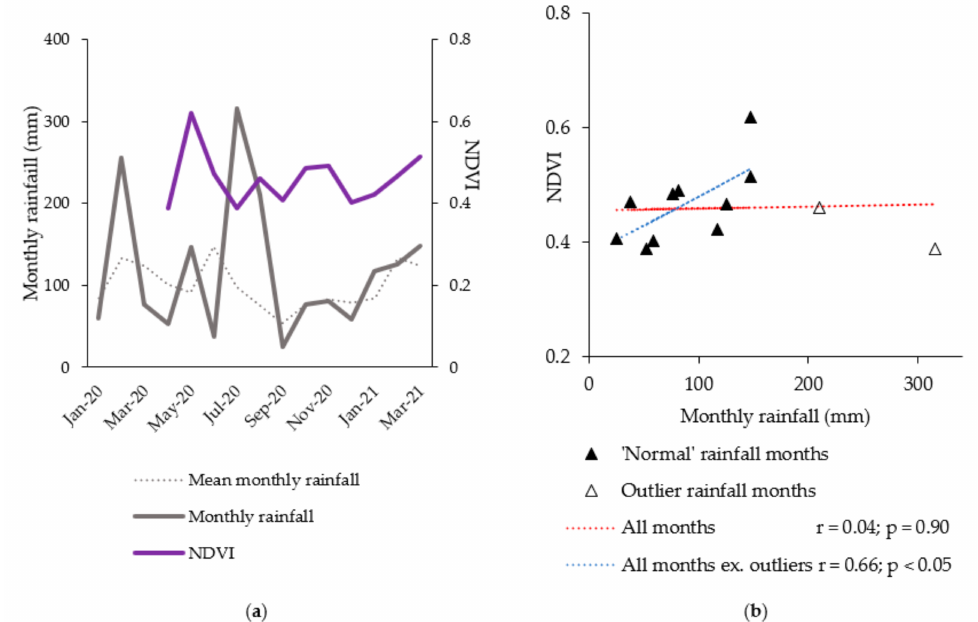
Figure 9. ( a ) Local monthly rainfall from January 2020 to March 2021 and mean monthly rainfall from all available years (Bureau of Meteorology, 2021) overlaid with mean PlanetScope NDVI for all saltmarsh quadrats ( n = 47). ( b ) Relationships between monthly rainfall (all months, and high rainfall outliers in July and August excluded) and PlanetScope NDVI for all saltmarsh quadrats ( n = 47)